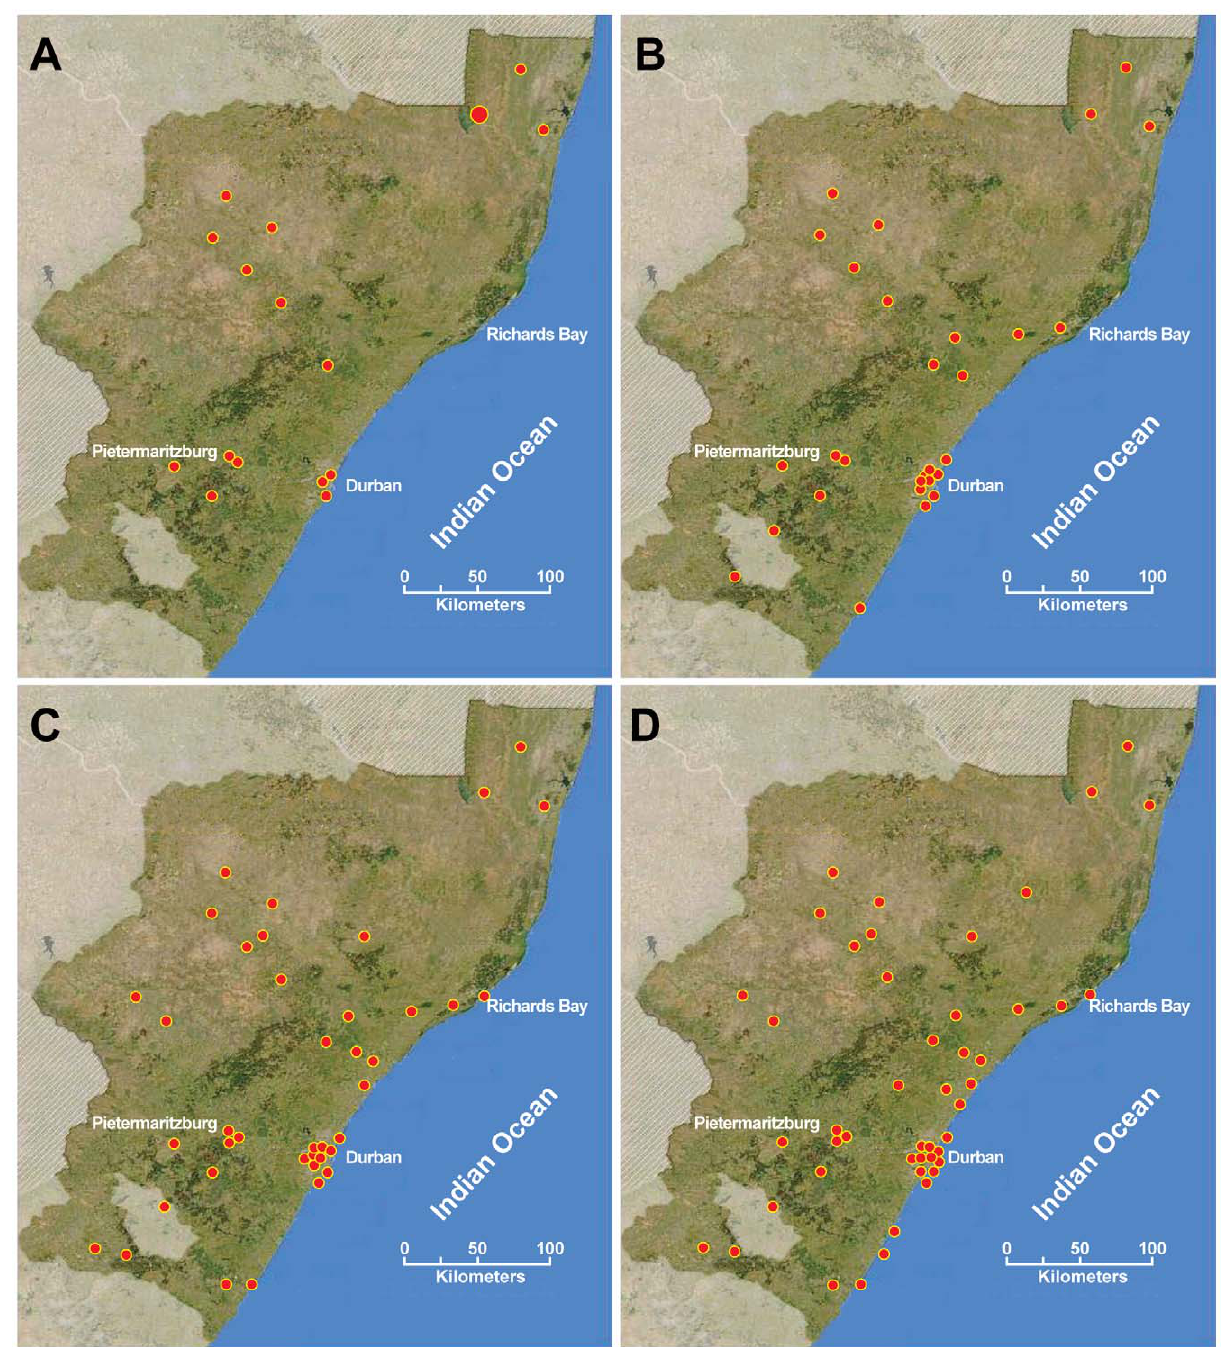
Figure 2. Geographical distribution and increase in number of hospitals with at least one case of XDR tuberculosis between January 2006 and June 2007. Each red dot depicts one hospital.